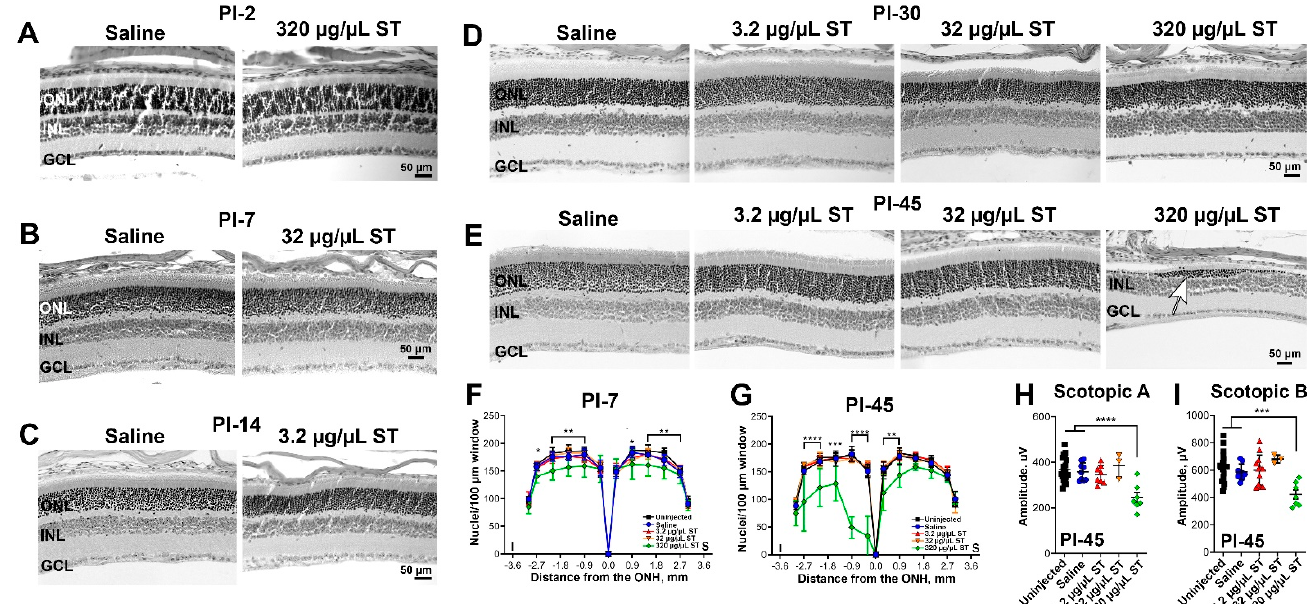
Figure 5. Low dose ST is safe in the retina. Adult Balb/C mice were intravitreally injected with 1.5 µL saline (vehicle) or sulfotyrosine (ST) at 3.2, 32 or 320 µg/µL. ( A – E ) Tissues were harvested at the indicated timepoints and retinal sections were H&E stained and imaged (original magnification 20×). White arrow highlights degenerated outer nuclear layer at PI-45 days in eyes injected with 320 µg/µL ST. ( F , G ) Outer nuclear layer nuclei were counted in retinal sections through the optic nerve collected at PI-7 ( F ) and PI-45 ( G ) days after ST injection. S: superior, I: inferior, and ONH: optic nerve head. Plotted is mean ± SD; * p < 0.05, ** p < 0.01, *** p < 0.001, and **** p < 0.0001 in comparison between uninjected and 320 µg/µL ST by 2-way ANOVA with Tukey’s multiple comparison test. ( H , I ) Full-field scotopic ERGs were recorded at PI-30 days. Plotted are mean ± SD; *** p < 0.001, and **** p < 0.0001 by one-way ANOVA with Tukey’s multiple comparison test. ONL: outer nuclear layer, INL: inner nuclear layer, GCL: ganglion cell layer, and ILM: inner limiting membrane. Scale bars: 50 µm. n = 3 retinas/timepoint/dose for histological analyses. n = 5–8 eyes/dose for ERG.